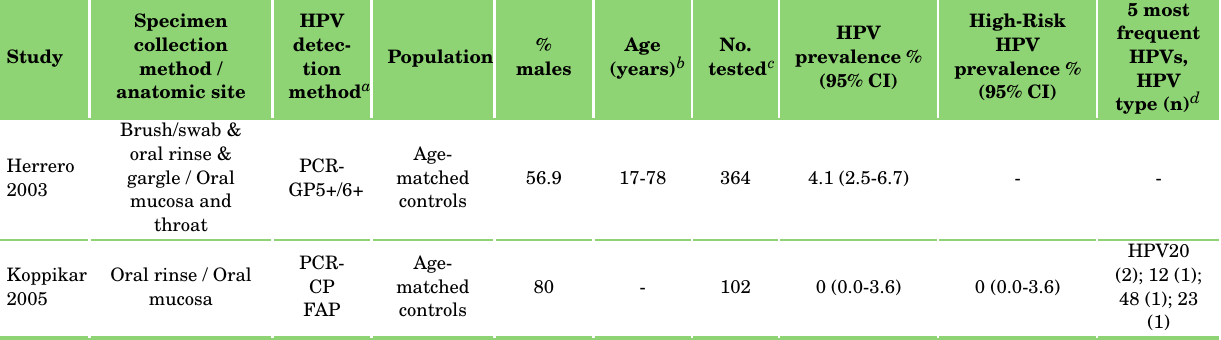
Table 35: Studies on oral HPV prevalence among healthy in